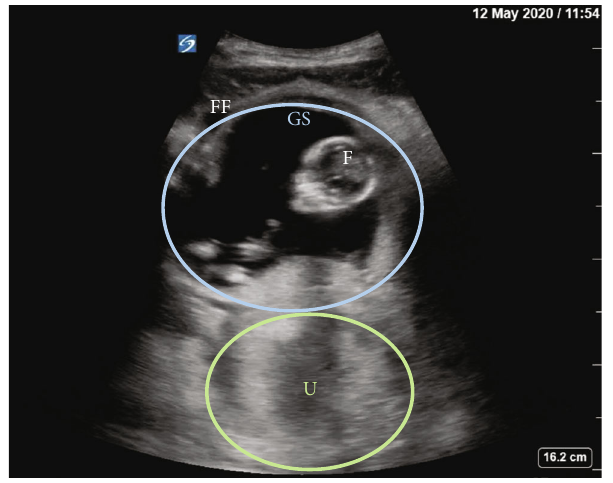
Figure 1: Bedside TAUS on visit 1. FF =free fl uid; GS =gestational sac; F=fetus; U=uterus.